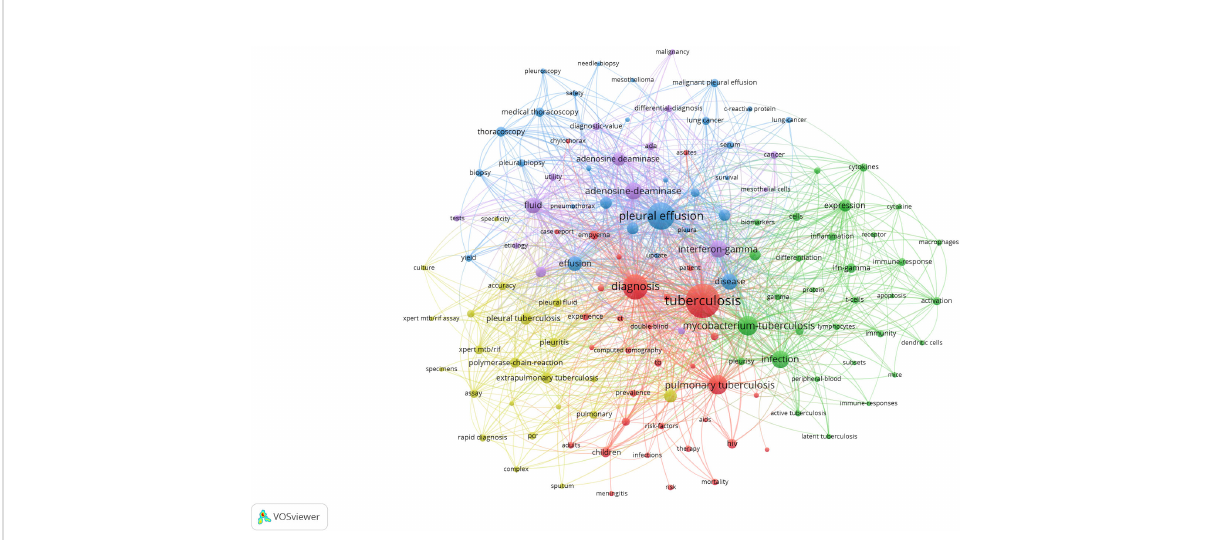
FIGURE 6 The mapping on keywords of tuberculous pleurisy. The 129 keywords that occurred more than 20 times were divided into fi ve clusters by different colors: cluster 1: red, cluster 2: green, cluster 3: blue, cluster 4: yellow, cluster 5: purple. The size of the nodes represents the frequency of